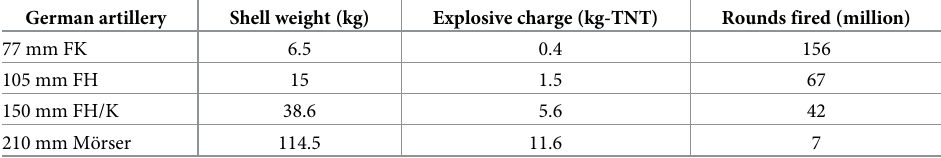
Table 3. German artillery rounds used in WWI